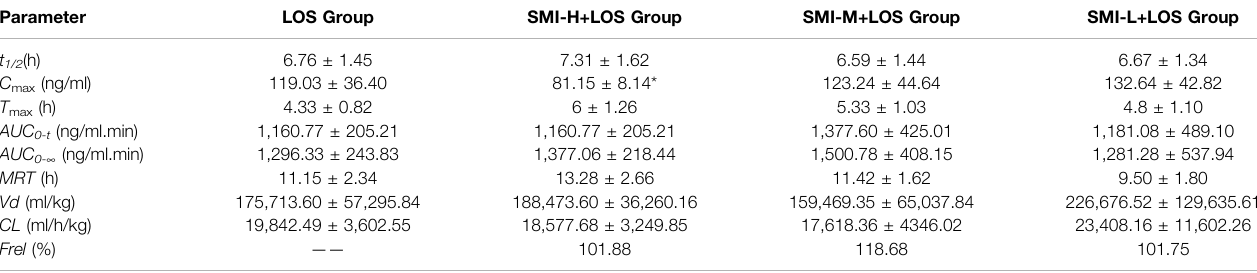
TABLE 3 | The pharmacokinetic parameters of LOS and EXP3174 in Wistar rat without L-NAME. Parameter LOS